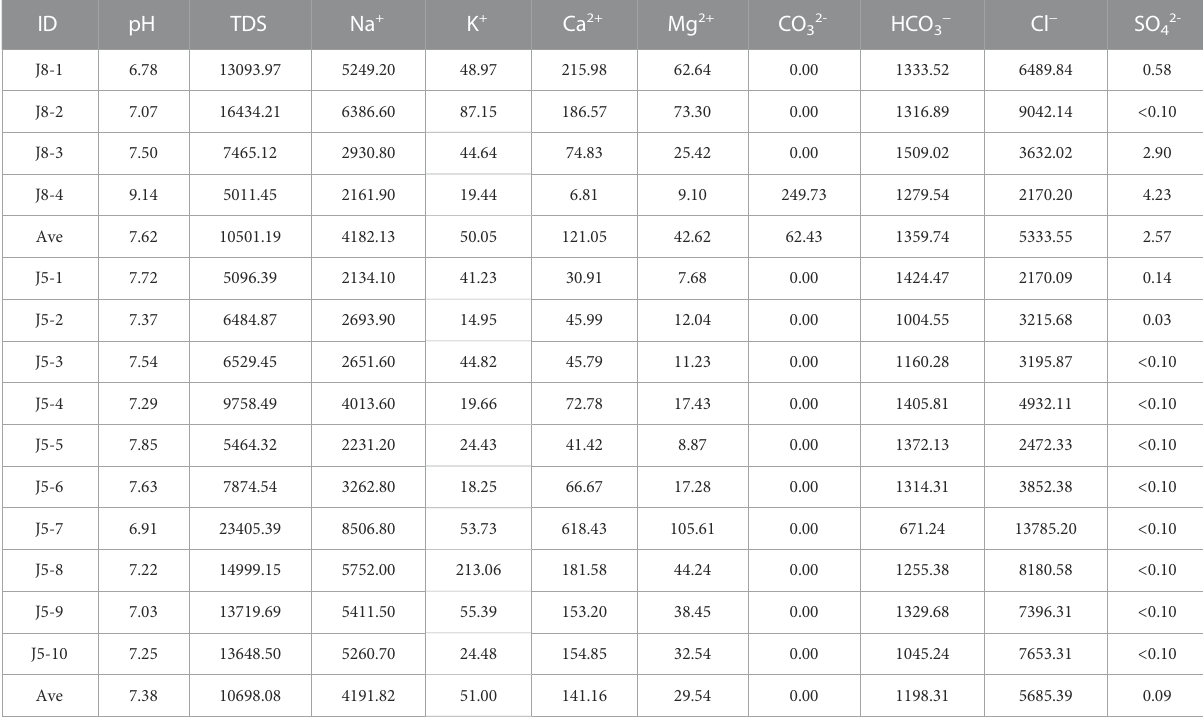
TABLE 1 Geochemical parameters of coalbed-produced water in the Linfen mining area (unit, mg/L). ID